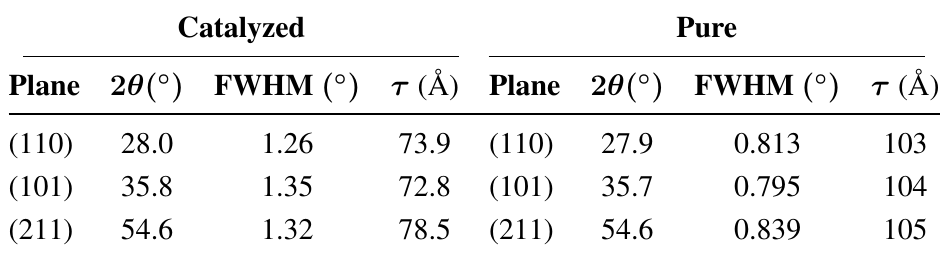
ball-milled for 120 min. 2